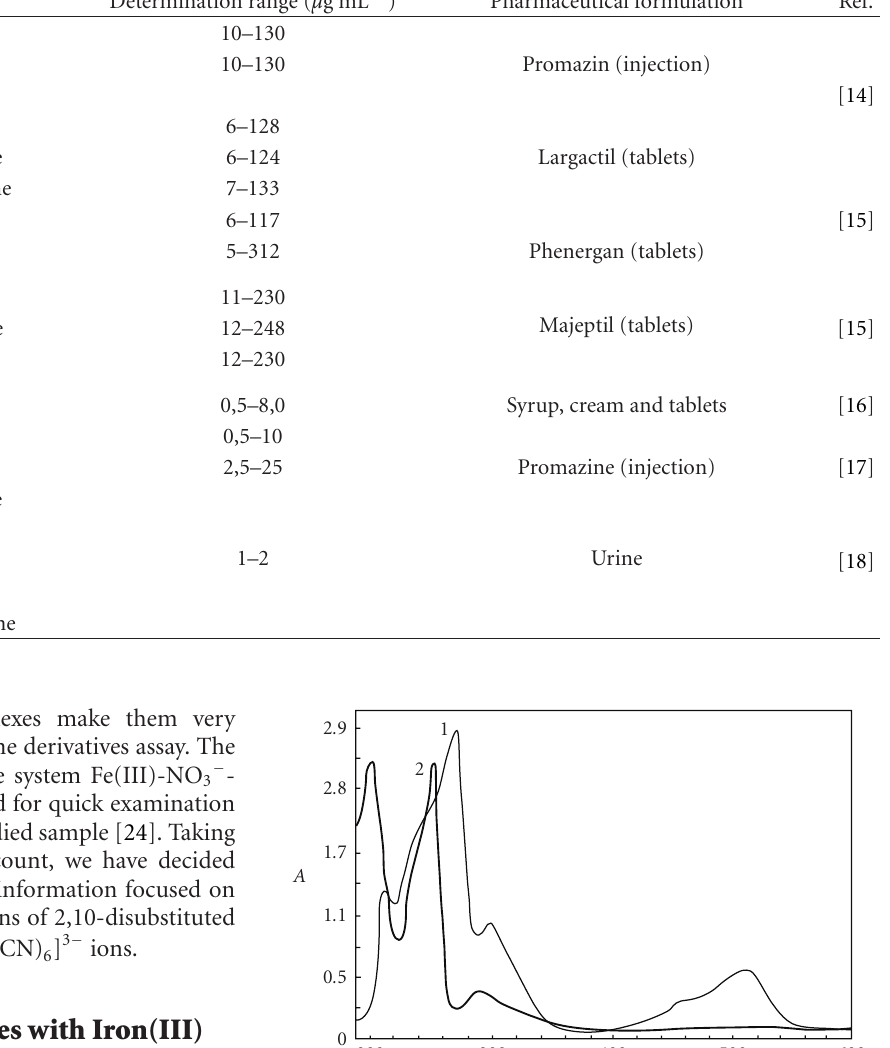
Table 2: Determination of some PF with Fe(III) and K 3 [Fe(CN)